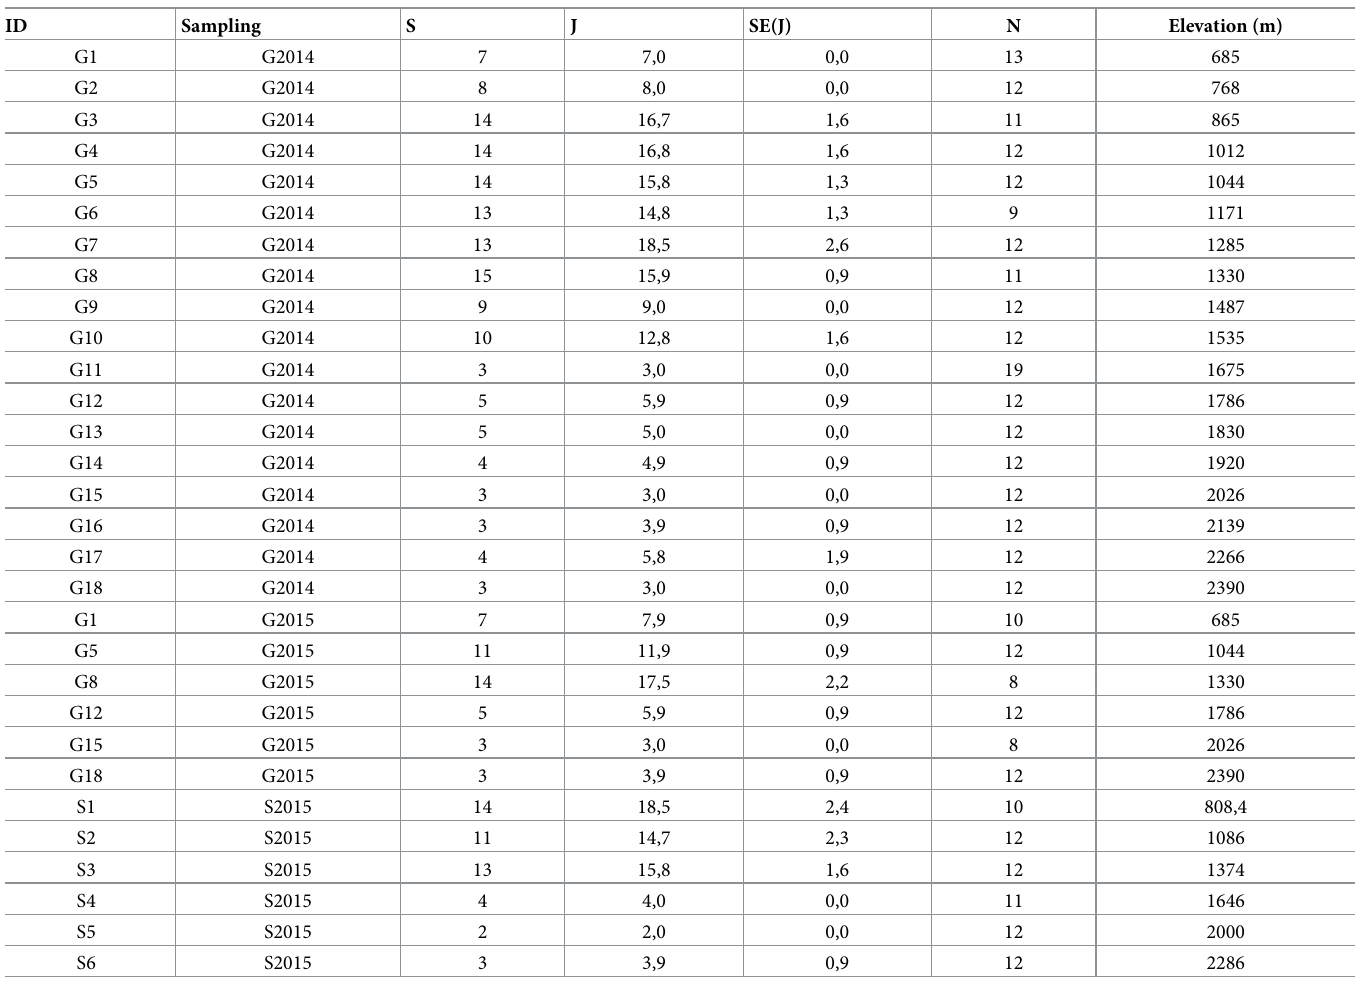
Table 1. Observed and estimated species richness of ants in dry grasslands in central